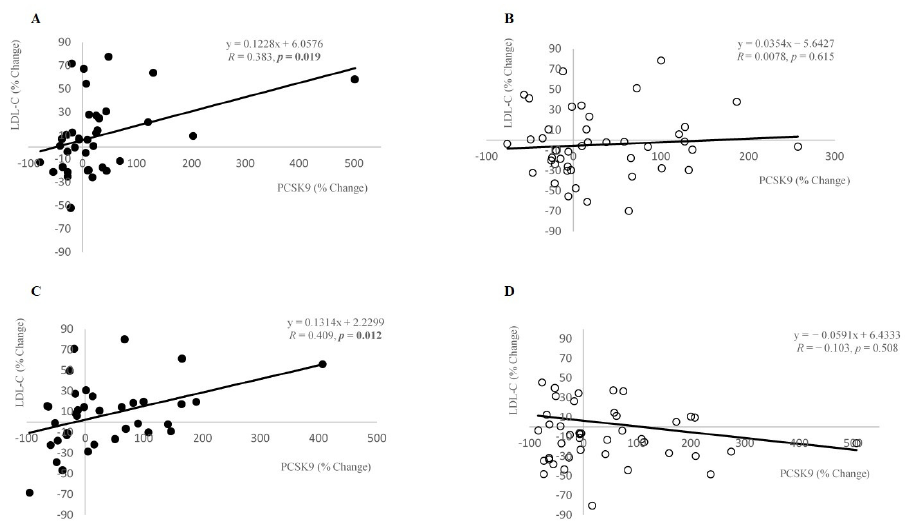
Figure 2. Comparison of atorvastatin-induced percentage changes in serum PCSK9 levels with percentage changes in serum LDL-C levels at 8 weeks ( A , B ) and 13 weeks ( C , D ). White circles ( ○ ) indicate the placebo and black circles ( ● ) indicate supplement. Abbreviations: LDL-C, low density lipoprotein cholesterol; PCSK9, proprotein convertase subtilisin kexin type 9. Significant negative correlation between the percentage change in PCSK9 levels and those in HDL-C levels was found after 8 weeks ( r = − 0.369, p = 0.025), but this correlation was lost at week 13, i.e., from baseline to endpoint ( r = − 0.276, p = 0.098) (Supplementary